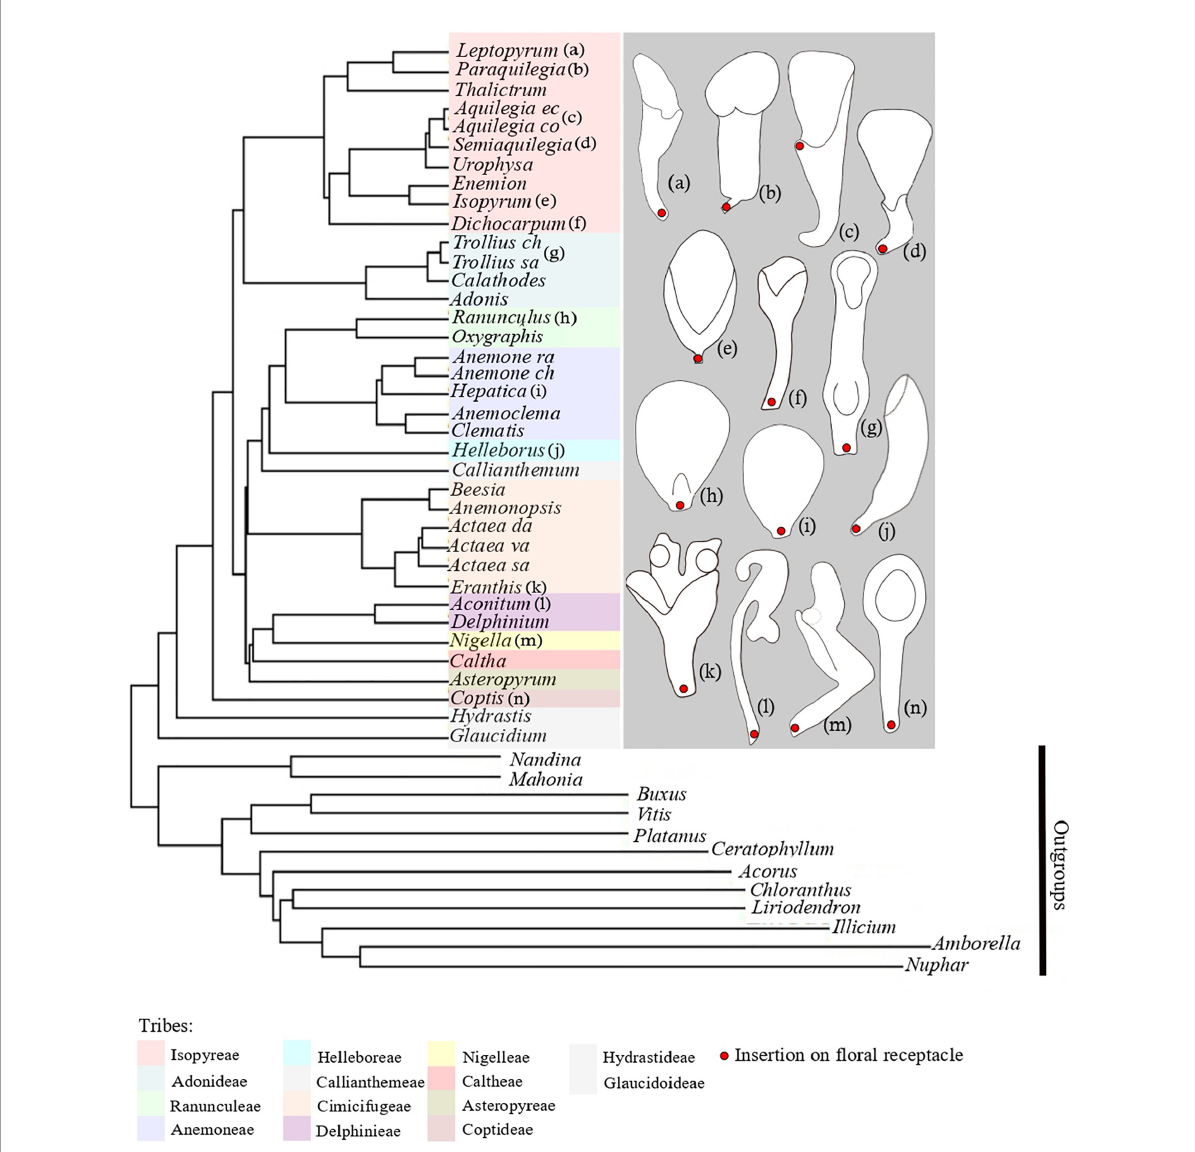
FIGURE1 Phylogenetic tree of Ranunculaceae, including representatives of all tribes of the family. Phylogenetic tree and tribal classification are adapted from Zhai et al. (2019). Species names missing are: Anemone raddeana, Anemone chinensis , Actaea dahurica, Actaea vaginata, Actaea asiatica, Trollius chinensis, Trollius saniculifolia, Aquilegia ecalcara, Aquilegia coerulea. On the right, schematic line drawings of a selection of petals displaying the morphological diversity of petals in Ranunculaceae. Letters a - n refer to the position of the species in the phylogenetiv